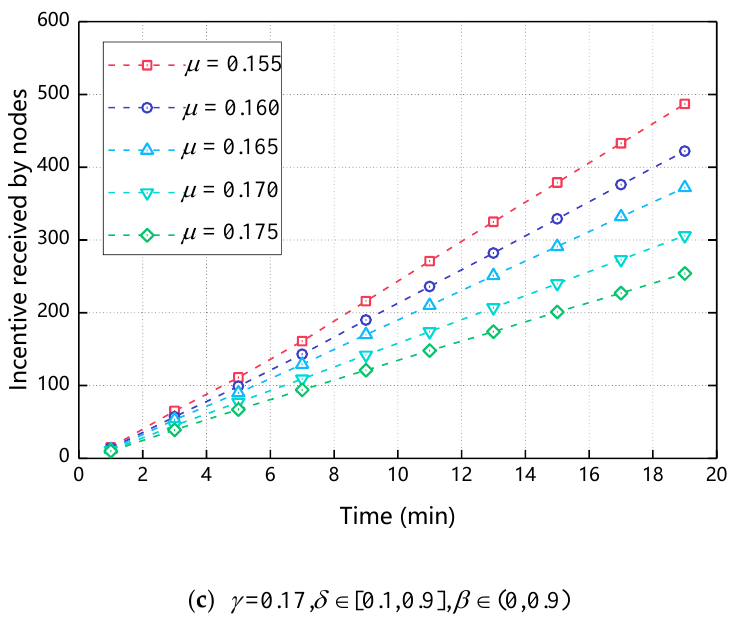
Figure 4. The impact of µ on incentive received by nodes.